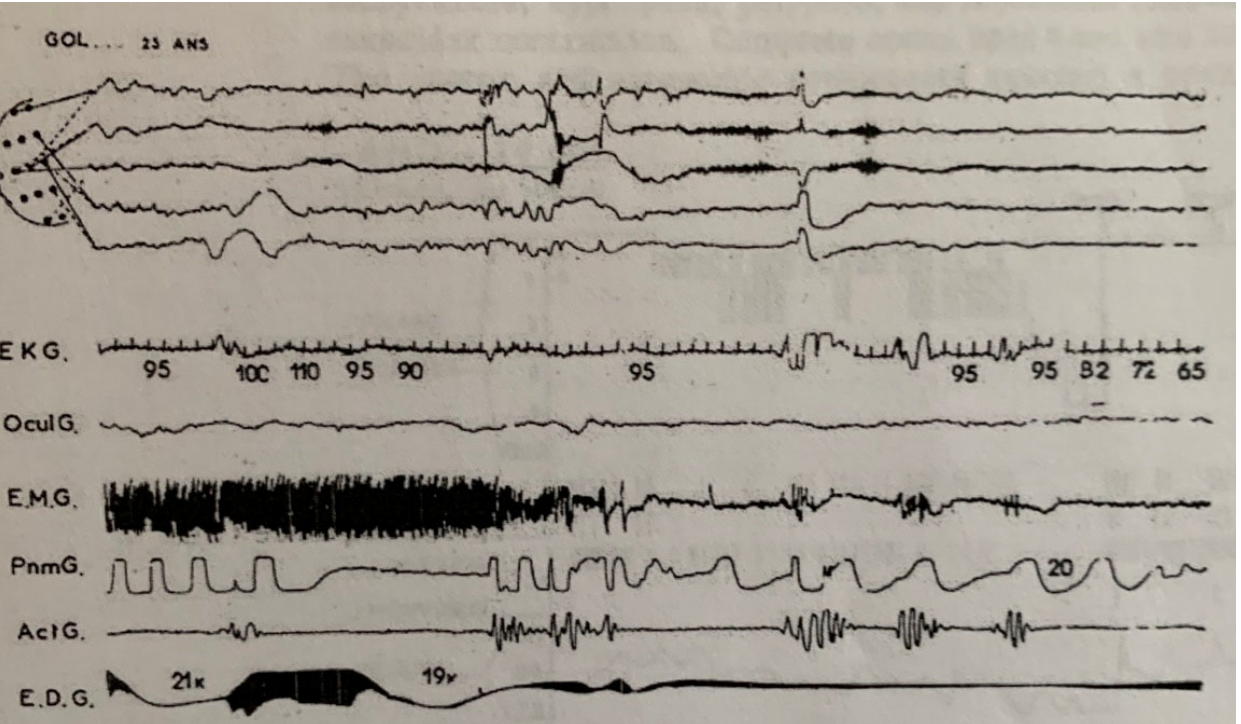
Figure 10. Continuation of the recording of a sleep terror. There is continuation of high muscle ten ‐ sion in the recording and the polypnea is stopped by an explosive bloodcurdling scream the heart rate has doubled from the level before the event and shows a maximum of 110 beats per minute. The actigraph documents significant body movements. This is followed by a progressive slowing of heart rate. The patient is not yet fully awakened and has had no eye movements typical of wakeful ‐ ness (Adapted from Gastaut, H. and Broughton, R.: A clinical and polygraphic study of episodic phenomena during sleep. Academic Address, in: Wortis, J. (Ed.), Recent Advances in Biological Psychiatry, New York, Plenum Press, 1965, pp. 197–221).